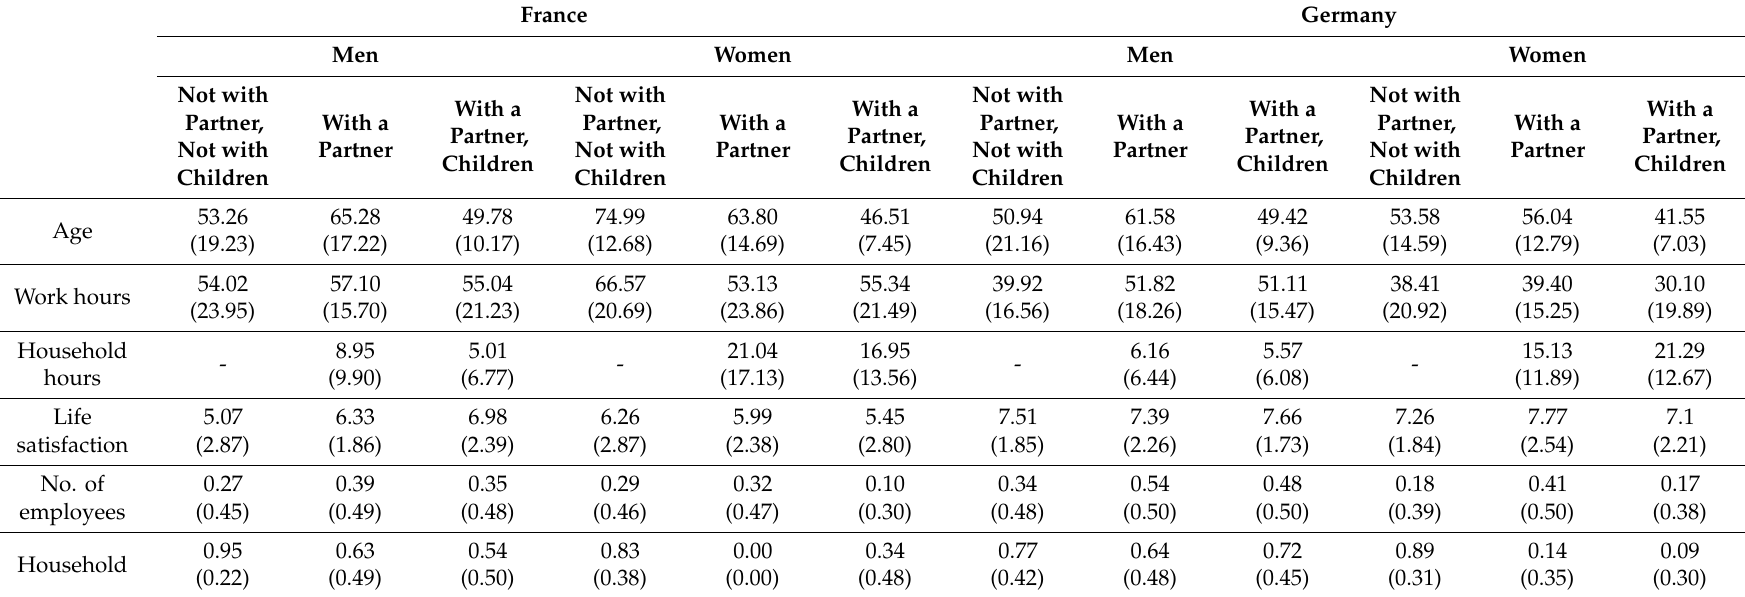
Table 2. Summary of descriptive statistics (means and standard deviations in